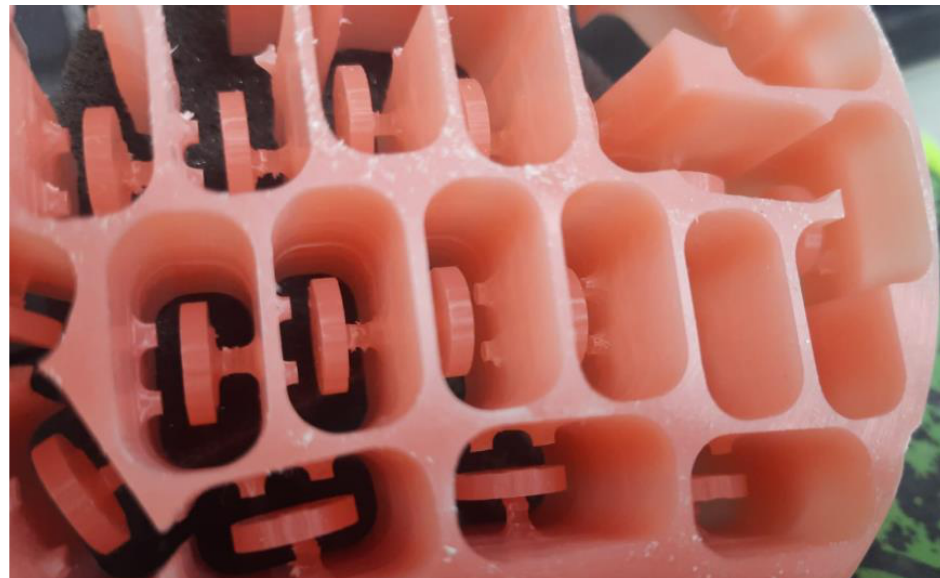
Figure 2. Specimens fabricated using CAD/CAM milling.